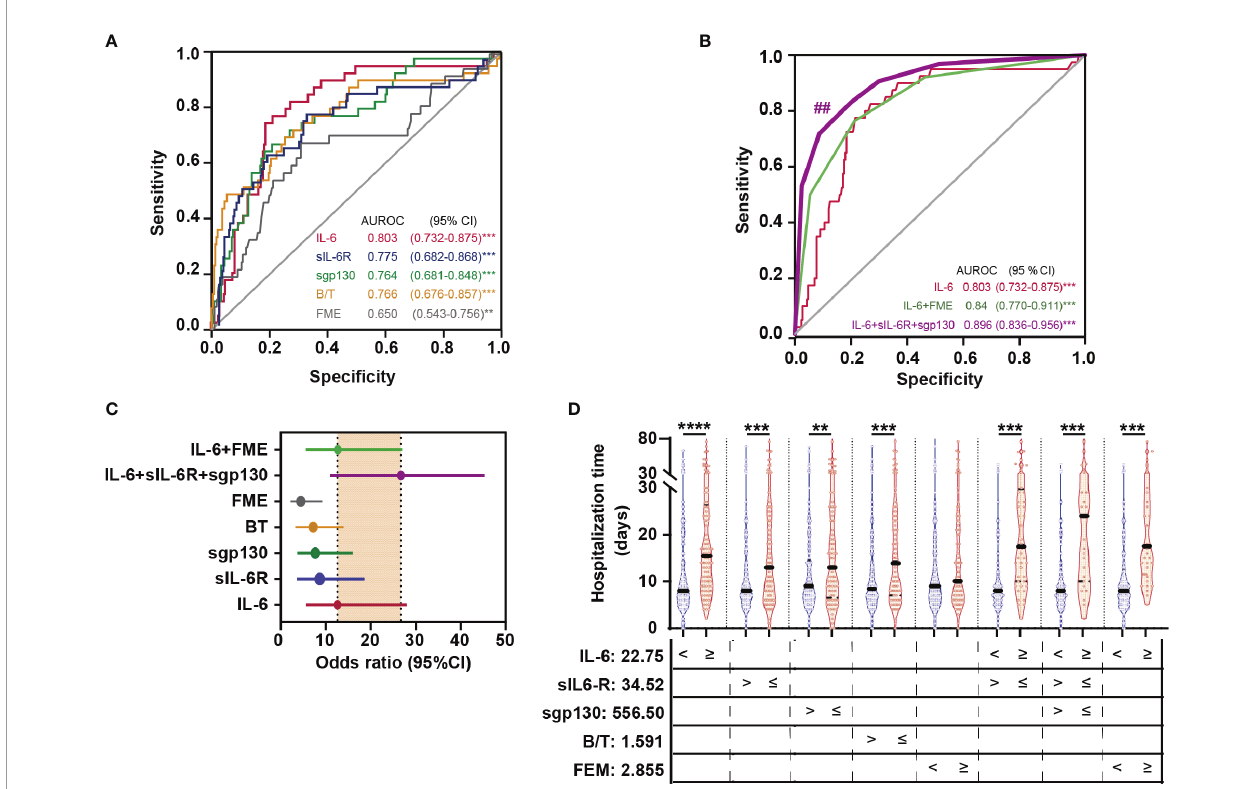
FIGURE 2 | IL-6 signalling biomarkers as predictors of severity without dead. AUROC curves (95% CI) of IL-6 signalling variables (A) , and scores combining IL-6 signalling variables (B) . Statistically signi fi cant differences among ROC curves were evaluated using DeLong ’ s test ## p < 0.01 vs IL-6 ROC curve. (C) Forest plots of OR summarizing the risk of severity for each variable or proposed score. (D) Violin plots indicating length of hospital stay (days) in patients according with levels of IL-6, sIL-6R, sgp130, Binary/Ternary complex ratio (B/T), and fold molar excess of sgp130 over sIL-6R (FME) above and below cut-off values. Each dot represents a sample; solid and dotted lines show the median and 95% CI, respectively. ** p < 0.01; *** p < 0.001.